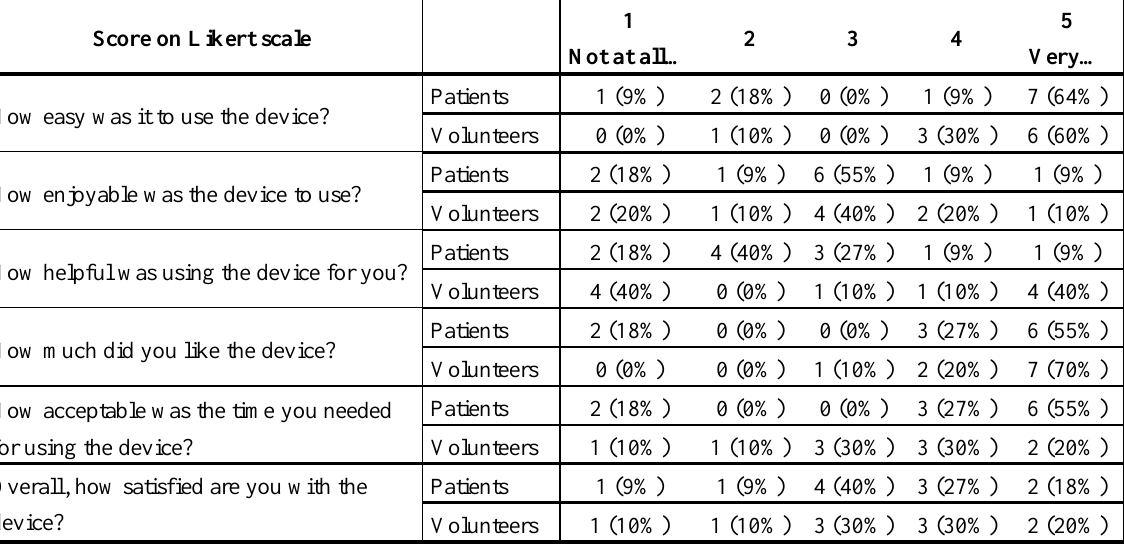
(patients: n = 11, volunteers: n =